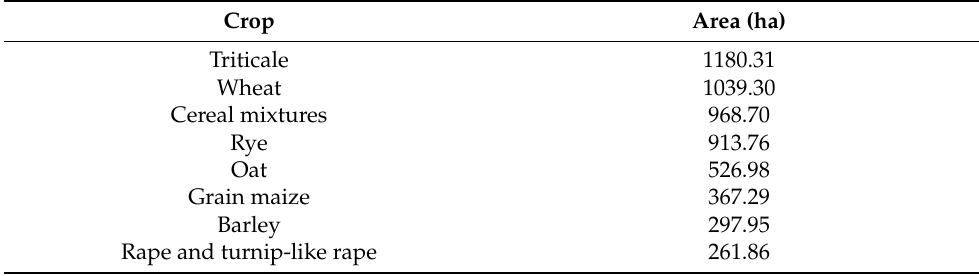
Table 2. Pattern of crops—exclusively main sources of straw.